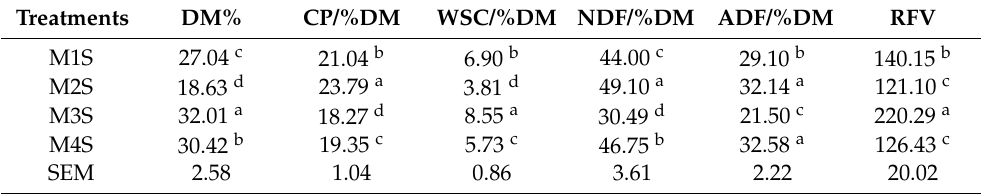
Table 3. Effects of maize varieties on the chemical composition of maize in maize–soybean inter- Table 4. Effects of maize varieties on the chemical composition of soybeans in maize–soybean intercropping. cropping.